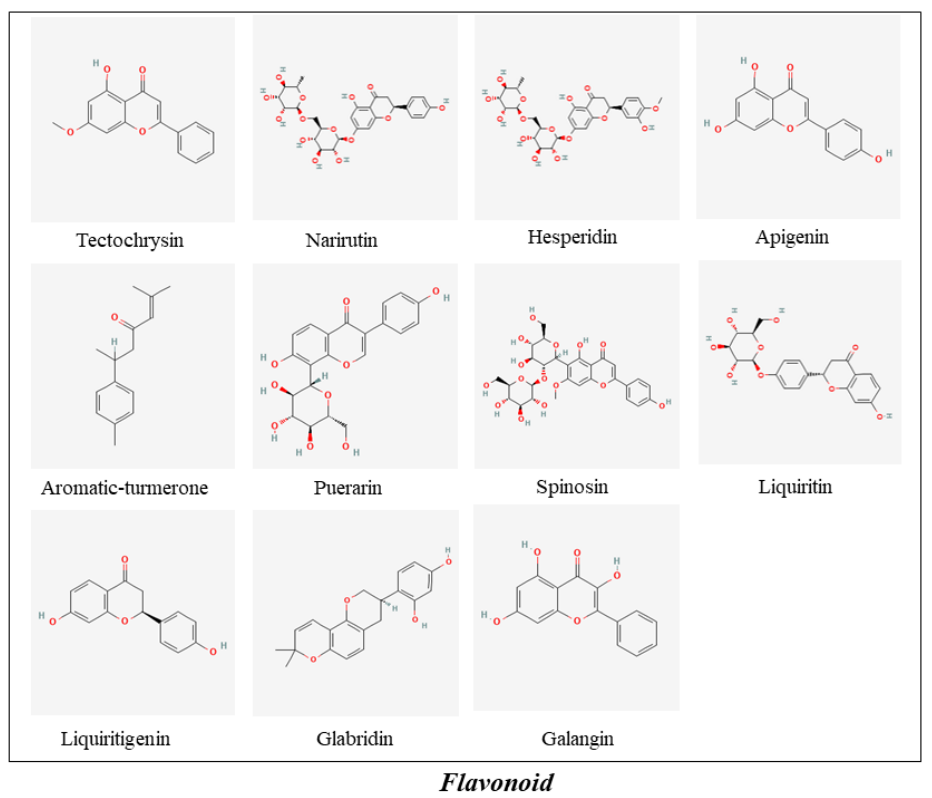
Figure 5. The ingredients of Flavonoid in MFH.